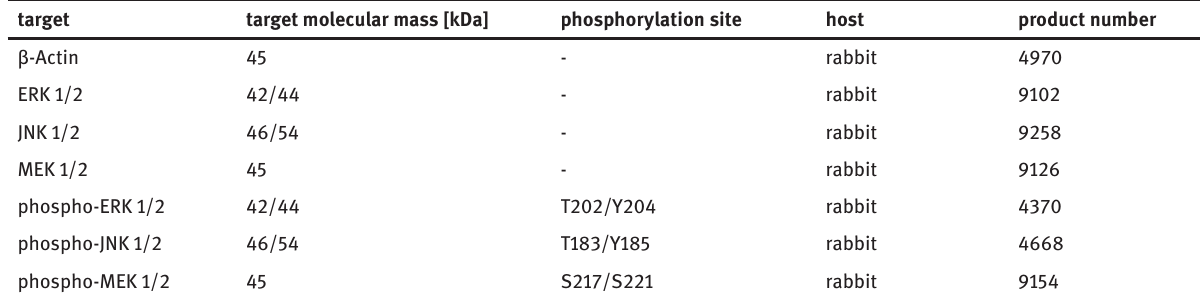
target target molecular mass